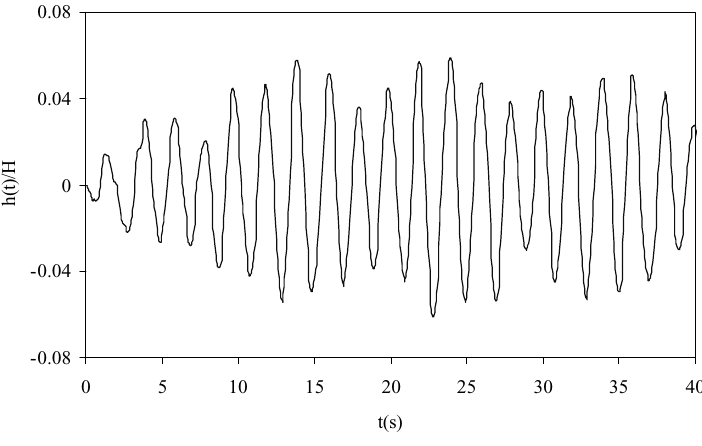
Fig. 10. Dynamic response h ( t ) of a three-span cable subject to vertical earthquake